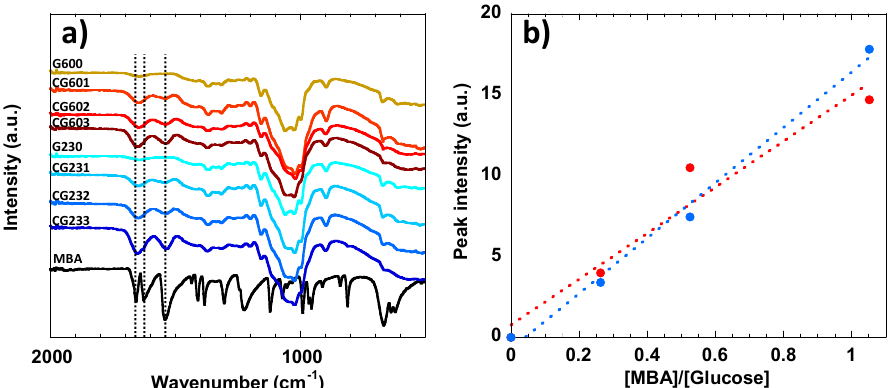
6 of 16 Figure 2. Storage modulus G’ (solid lines) and loss modulus G’’ (dashed lines) of 2 wt.% cellulose solutions with different MBA/glucose molar ratios: 0 (black), 0.26 (red), 0.53 (green) and 1.05 (blue) cured in different conditions: ( a ) temperature ramping from 23 °C to 60 °C during the first 10 min followed by 20 min at 60 °C, ( b ) cured at 23 °C for 720 min. 3.2. FTIR and Raman Analysis of Accessibility of Cellulose Hydrogel In order to shed light into the cellulose-MBA cross-linking mechanism and hydrogel formation, a detailed FTIR analysis was performed. Figure 3a shows the FTIR spectra of the MBA and non-cross- linked cellulose references, and those of the cross-linked cellulose hydrogels cured at different conditions. In the MBA spectrum, the typical absorption bands for -C=O, C=C and -NH can be highlighted at 1656 cm − 1 , 1621 cm − 1 and 1540 cm − 1 , respectively [69–71]. Once the cellulose hydrogel is formed, the C=C vibration band at 1621 cm − 1 vanishes, which suggests that the double bonds were consumed during the crosslinking reaction. At the same time, in the hydrogel, the -C=O (1656 cm − 1 ) and -NH (1540 cm − 1 ) vibrational bands are still identifiable, which suggests that MBA was successfully grafted onto the cellulose chains. Regardless of the temperature, it can be noted that the